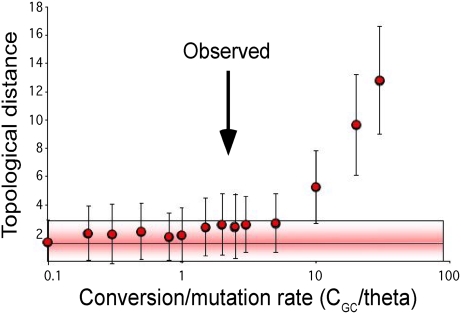
Impact of gene conversion rate on phylogenetic reconstruction.Sets of 20 sequences of 25 kbp were simulated 100 times under different gene conversion rates with constant tract length (50 bp) and mutation rate. The topology of the “true” genealogy of the sample (as inferred from a single nucleotide on which no gene conversion was allowed) was compared, using Robinson and Foulds distance, to the topology inferred from phylogenetic tree reconstruction using the simulated sequences. Error bars indicate one standard deviation variance, and horizontal bars represent one standard deviation variance from the no-gene-conversion model. A high rate of gene conversion is required to affect the topology of the reconstructed phylogeny. The observed average ratio of gene conversion to mutation (CGC/theta) is indicated by an arrow.